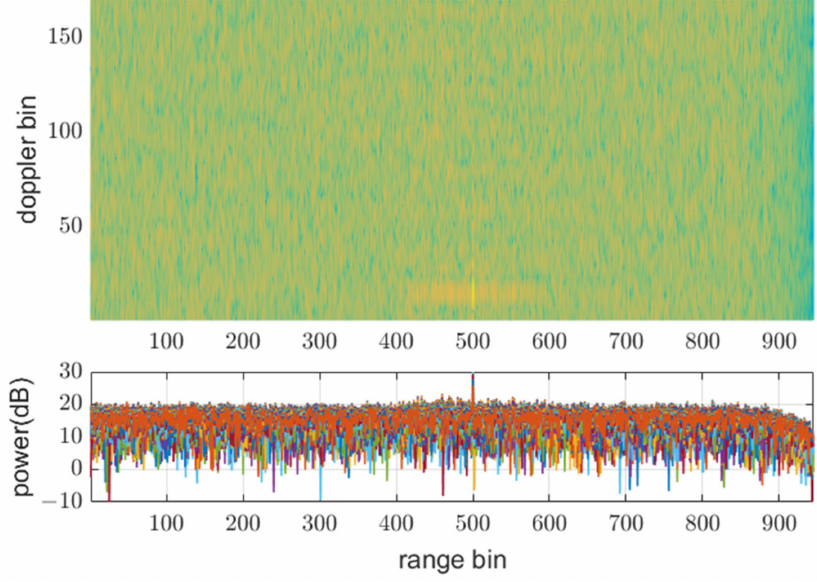
Figure 11. Doppler processing out in Rx1-3 using different PRFs at SNR i = 0